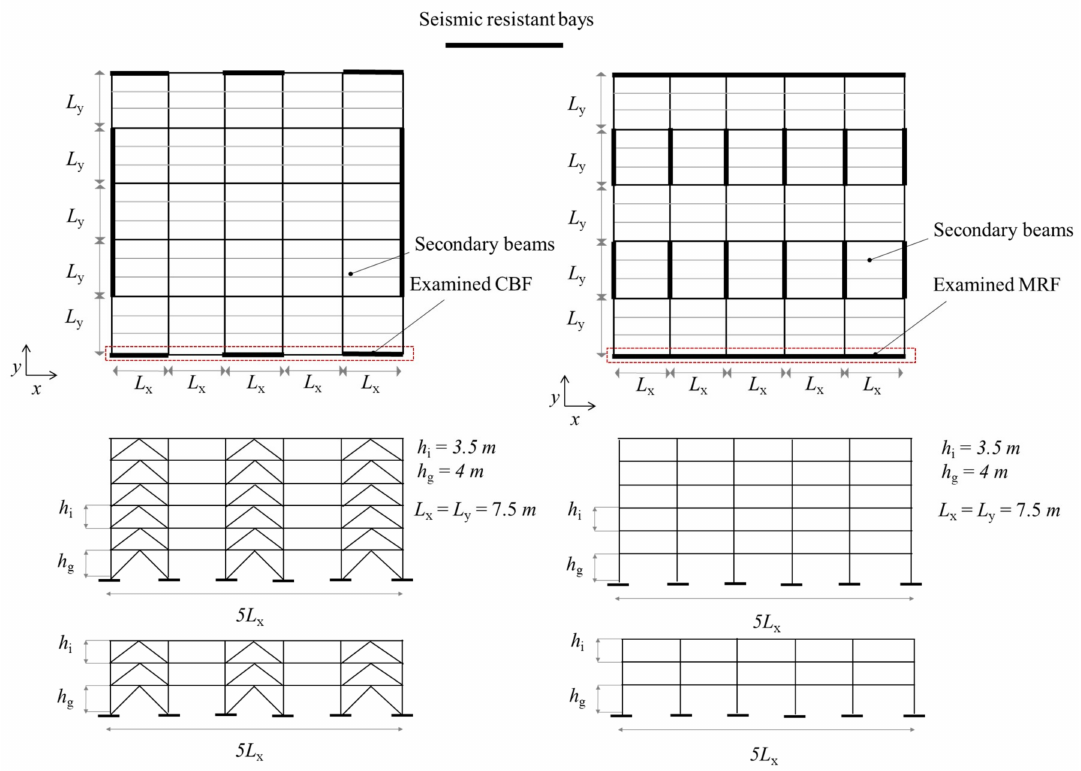
Figure 1. Reference buildings in plan and